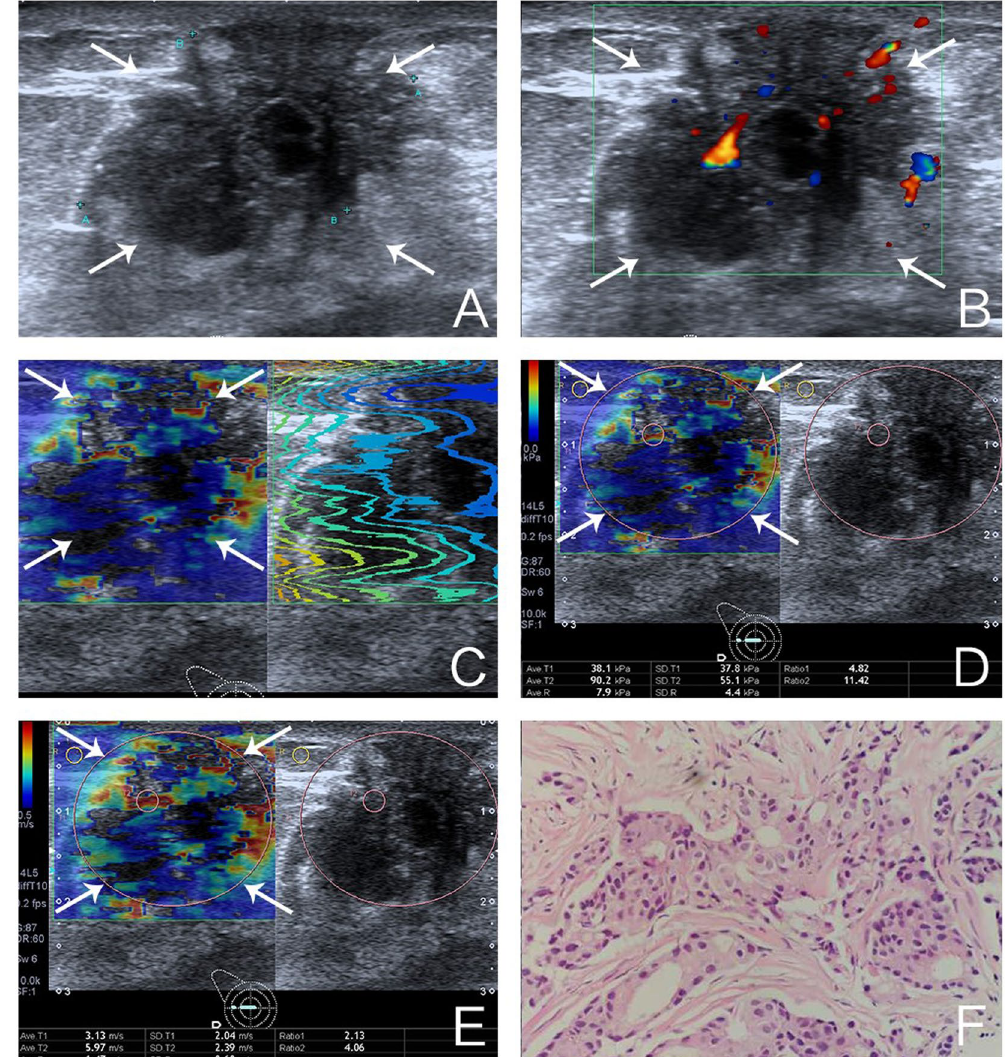
Figure 2. Images of a 57-year-old woman with invasive ductal carcinoma. ( A ) The lesion is shown on B-mode ultrasound. ( B ) The lesion is shown on color Doppler ultrasound ( C ) shear wave arrival time contour of the lesion shows distorted and unparalleled lines on the shear wave propagation mode. ( D ) The mean and standard deviation of the lesion on elasticity mode are 38.1 kPa and 37.8 kPa, respectively. ( E ) The mean and standard deviation of the lesion on shear wave speed mode are 3.13 m/s and 2.04 m/s, respectively. ( F ) Pathological examination confirms the diagnosis of invasive ductal carcinoma (Hematoxylin-eosin stain; × 200).